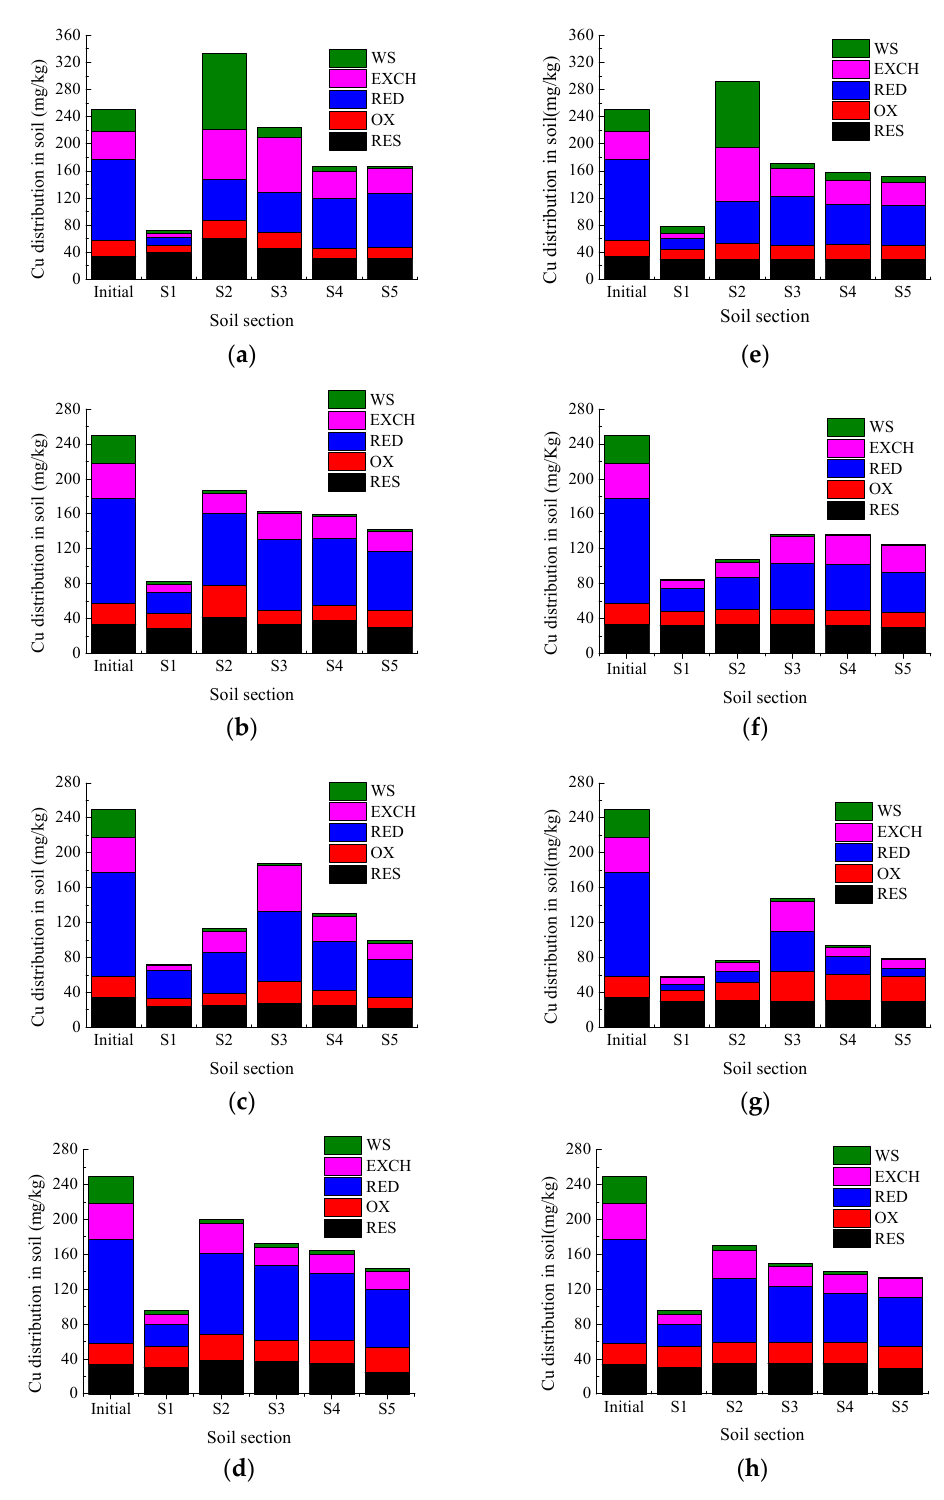
Figure 7. Fractionation change of Cu after EK tests. ( a ) Test 1; ( b ) Test 2; ( c ) Test 3; ( d ) Test 4; ( e ) Test 5; ( f ) Test 6; ( g ) Test 7; ( h ) Test 8. Table 4. Results of fractionation change of Cu after EK tests.